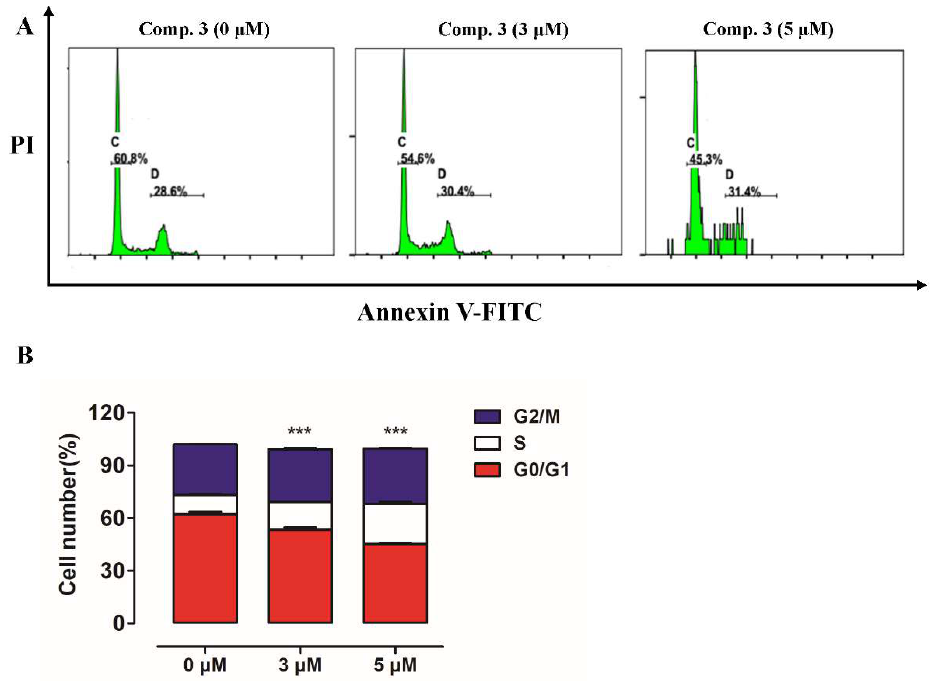
Figure 9. Cell cycle analysis of A549 cells after treatment with compound 3 . After 24 h of treatment, cells were labeled with PI (Propidium Iodide) and cell cycle analysis was performed using flow cytometry. ( A ) Representative histograms. ( B ) Quantitative analysis. Data are expressed as means from three independent experiments. *** p < 0.001 vs control group.